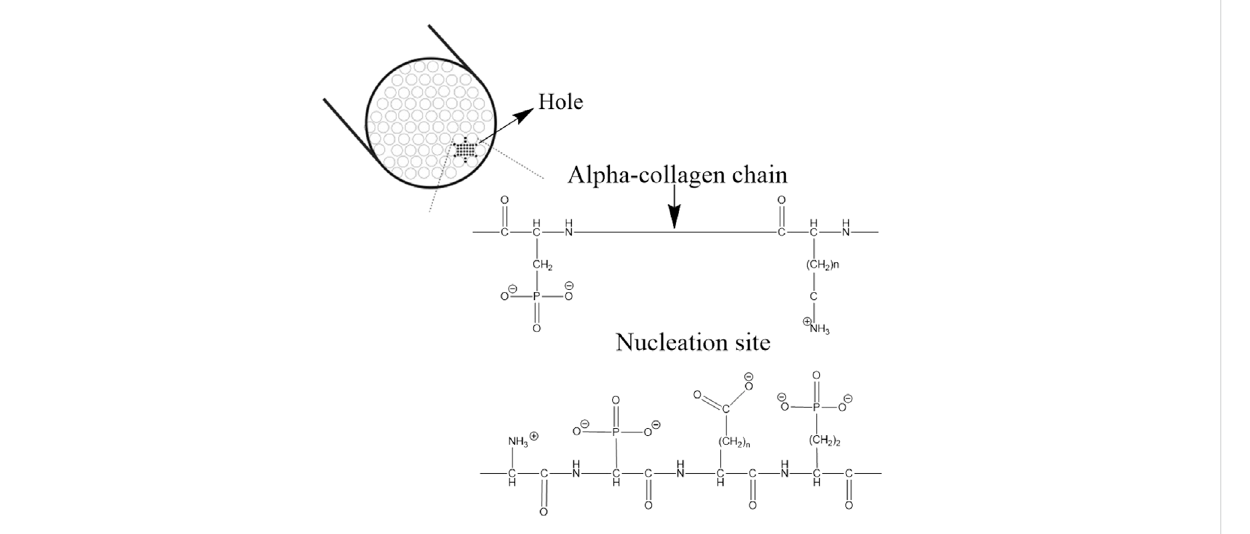
FIGURE 3 Nucleation sites in the hole zone of the alpha-collagen fi bril. The image is inspired by the work of (Glimcher,